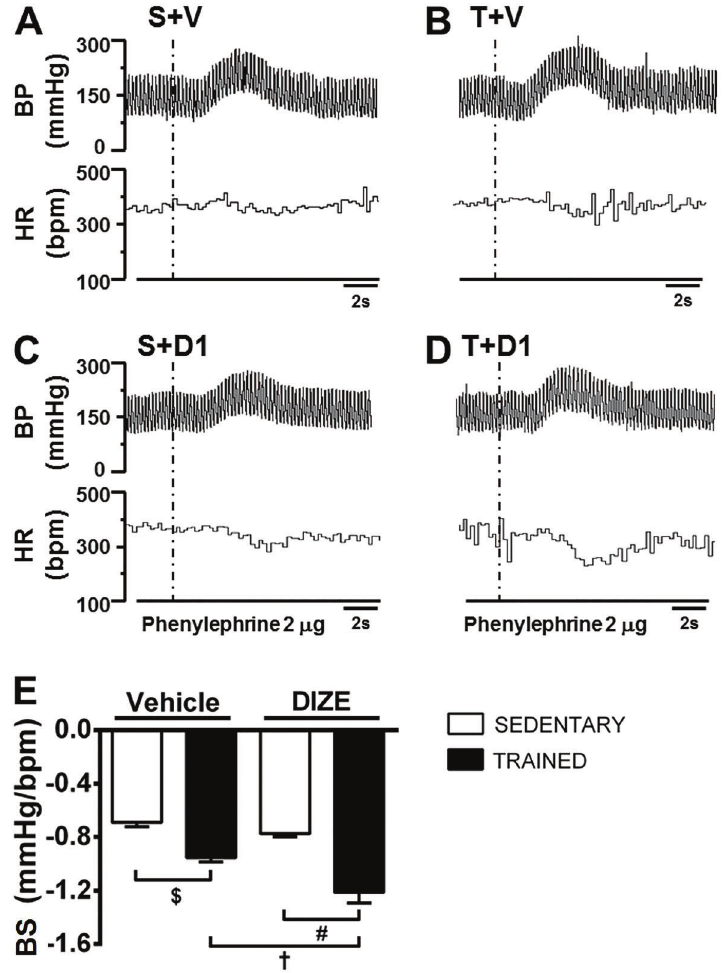
Figure 2. Representative traces of the cardiovas- cular responses induced by phenylephrine infu- sions in sedentary rats receiving vehicle (S + V; A ), trained rats receiving vehicle (T + V; B ), sedentary rats receiving diminazene aceturate (DIZE; 1 mg/ kg) (S + D1; C ) and trained rats receiving DIZE (T + D1; D ). Barore fl ex sensitivity (BS) is reported as the ratio between changes of heart rate (HR) and mean arterial pressure (MAP) induced by phenylephrine infusion ( E ). $,#, w P o 0.05 (ANOVA followed by the Fisher LSD post hoc